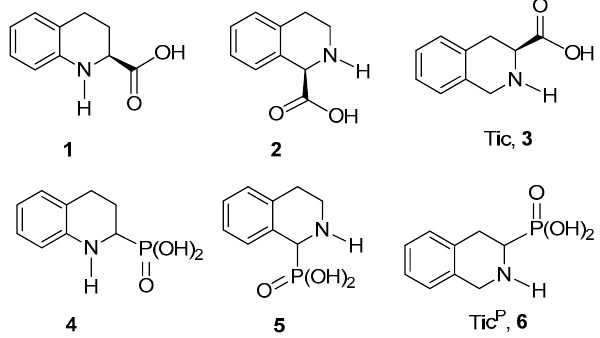
Figure 1. α -Amino acids characterized by a tetrahydroquinoline or tetrahydroisoquinoline heterocyles and their α -amino phosphonic analogues.